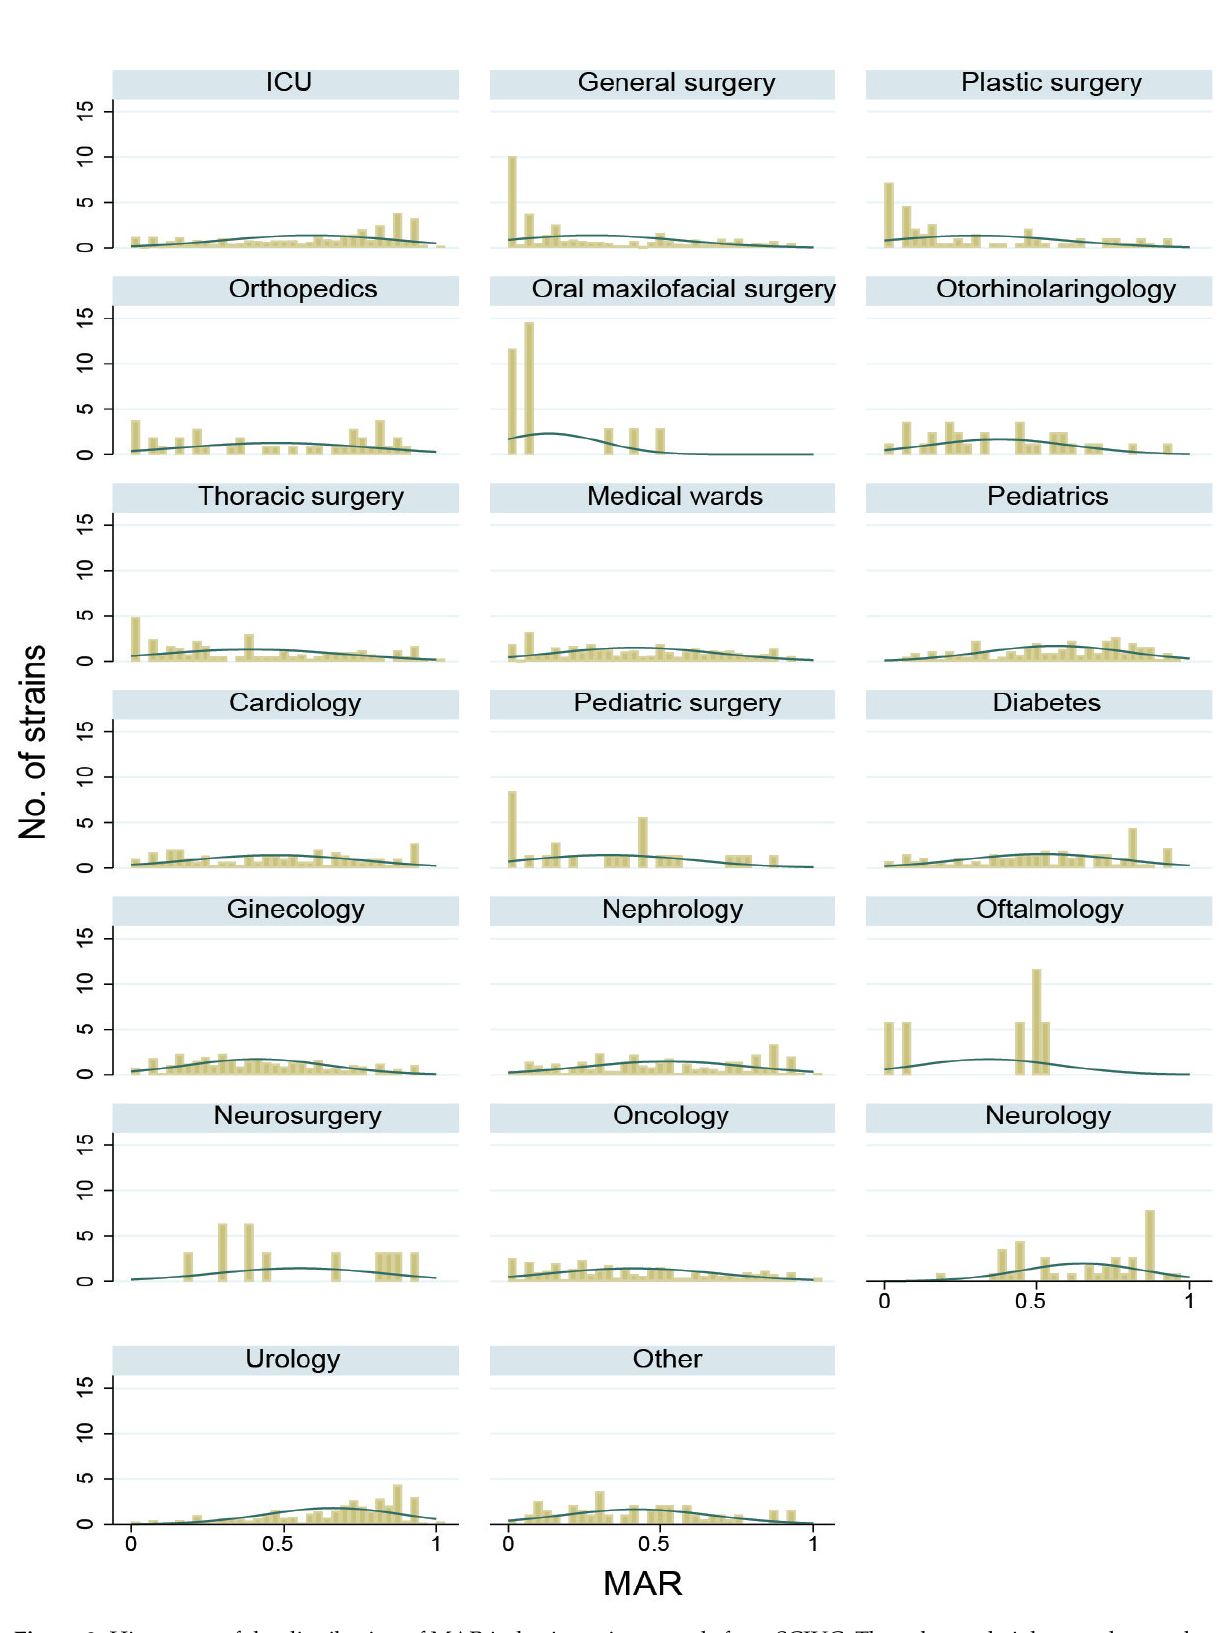
Figure 3. Histogram of the distribution of MAR index in various wards from SCJUC. The columns heights are the number of strains for which MAR falls in a specific interval (bin). The green line is a smoothing line of the heights of the bars.